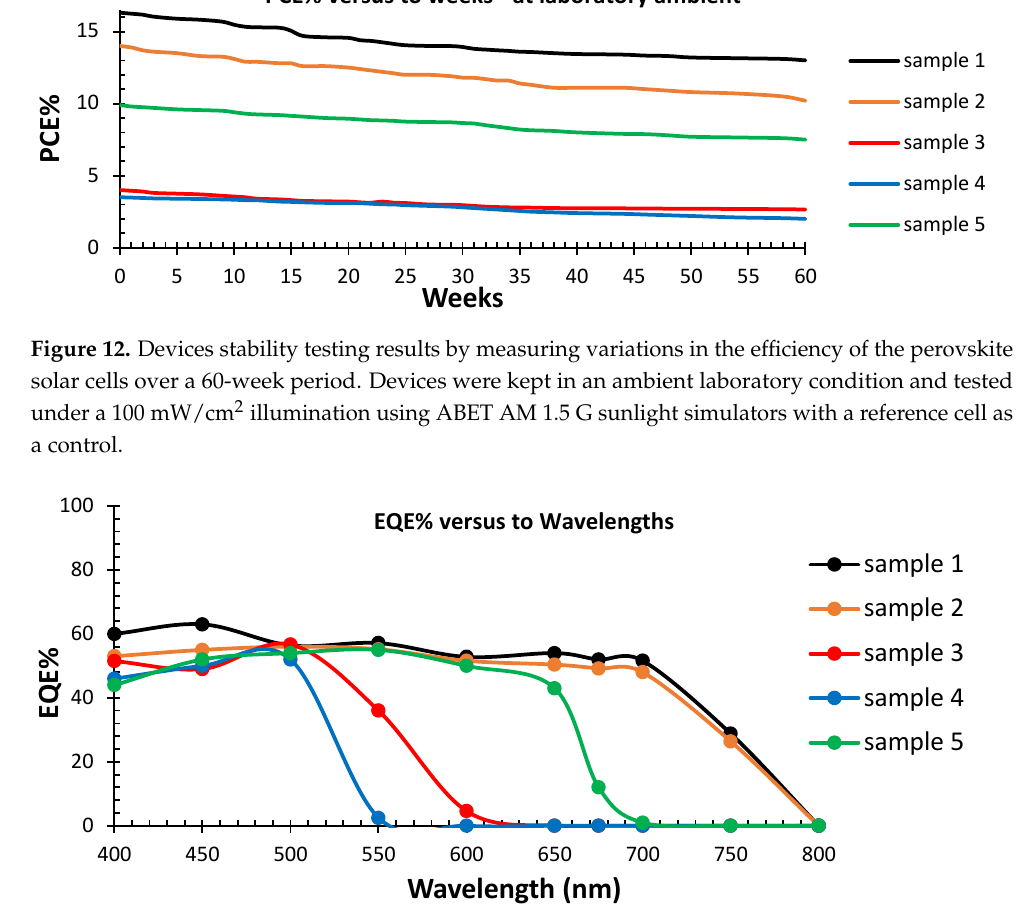
Figure 13. External quantum efficiency spectra of the perovskite solar cells prepared with different compositions.